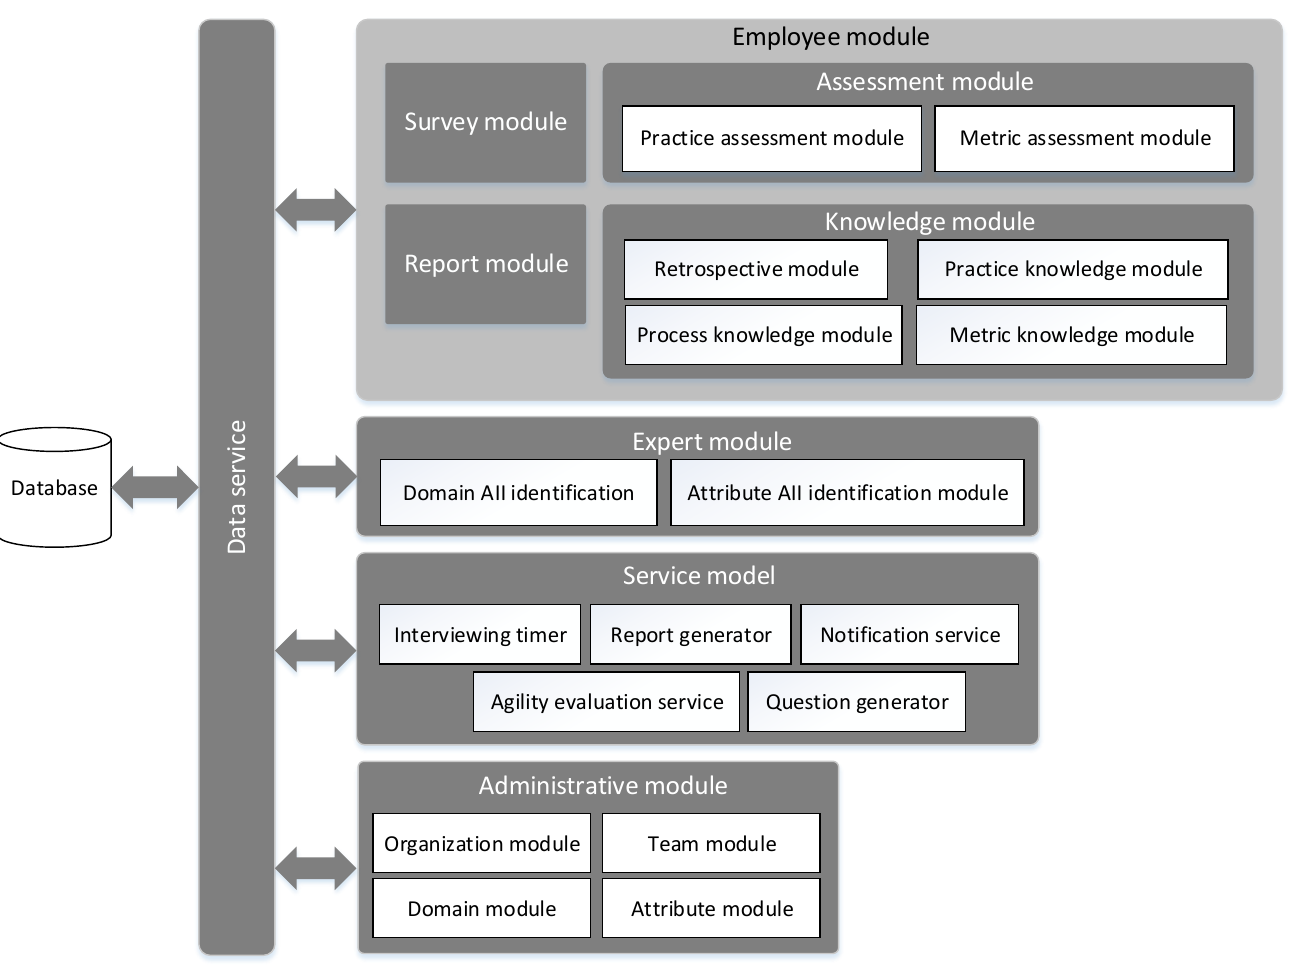
Fig. 4. Architecture of the evaluation